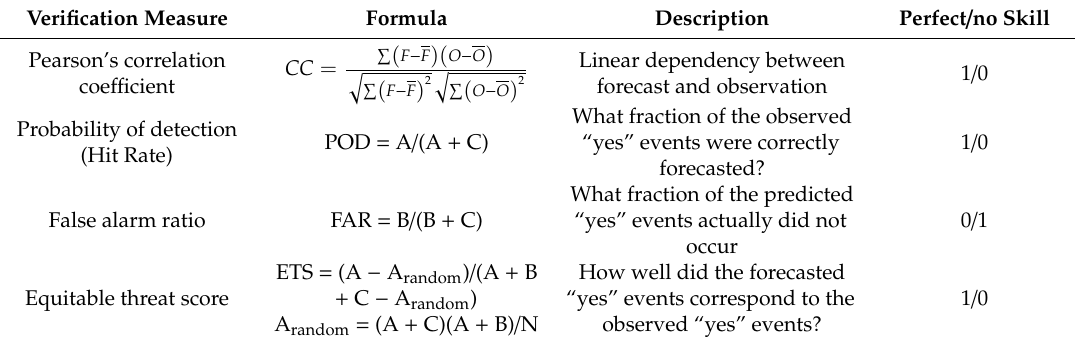
Table 2. Summary of the assessment criteria used in this study